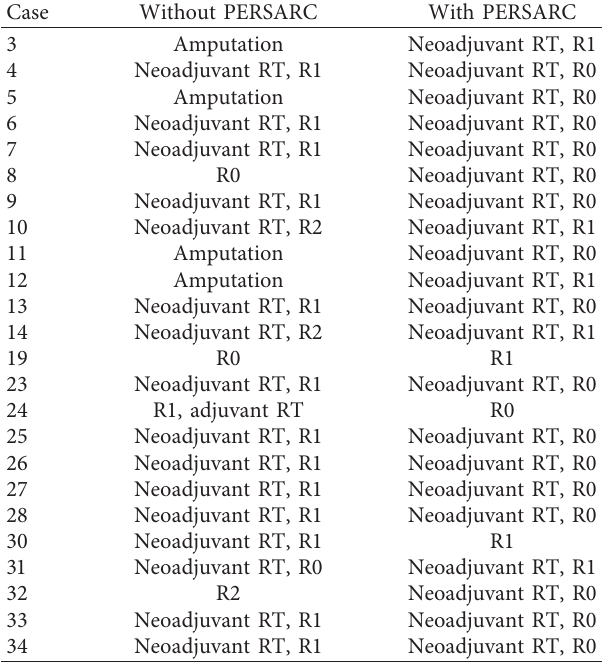
Table 5: Changes in the treatment protocol per case ( N � 24) with the use of